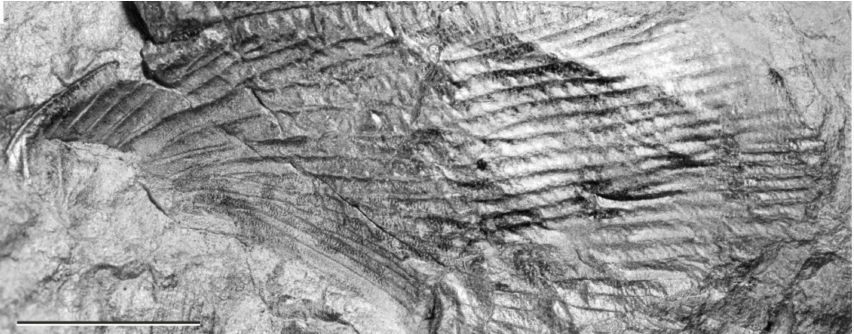
Figure 15. Progonoblattina helvetica (Heer, 1864): specimen to ‘ Hispanoblatta cantabrica ’ Laurentiaux, 1958 (unpubl.), nomen nudum; San Felices de Castilleria; MGBNH 7149B; preserved length c. 40 mm; scale bar 5 mm; photo: from Laurentiaux